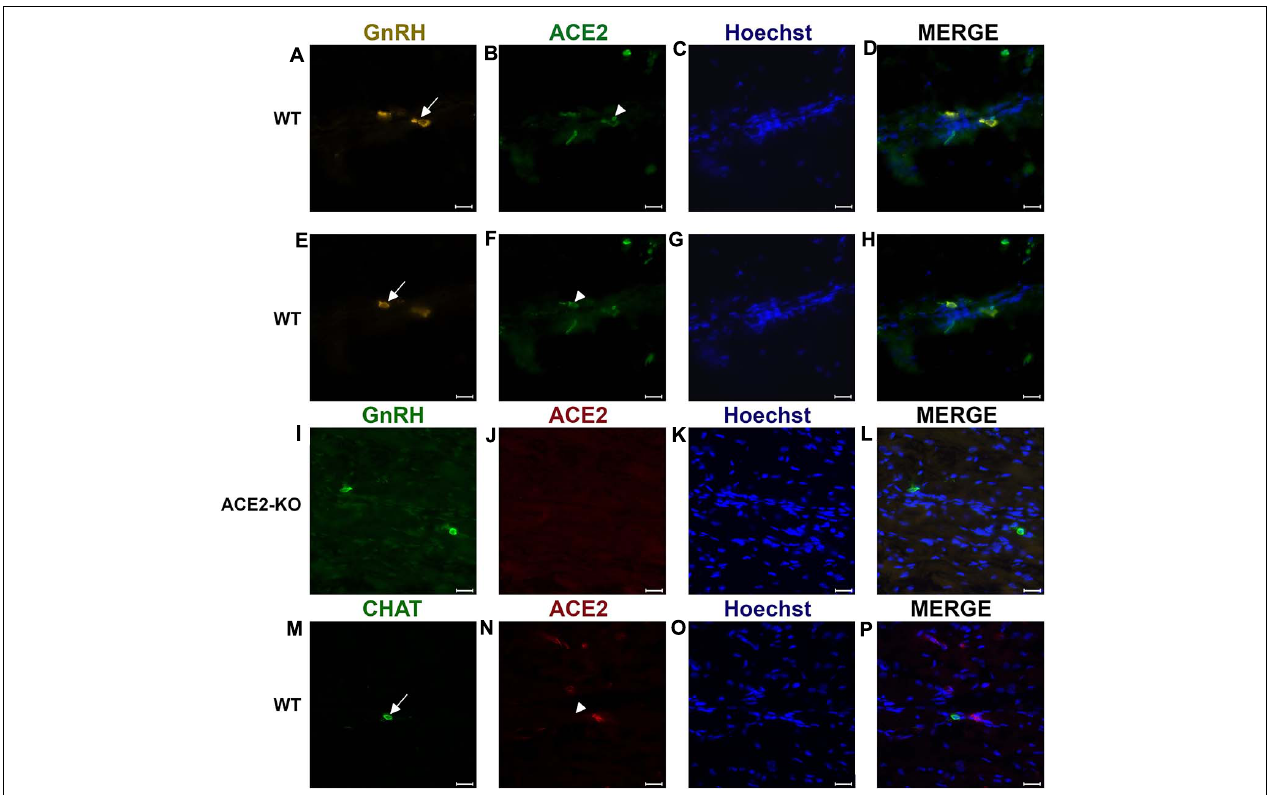
FIGURE 2 | Examples of double immunofluorescent labeling for nervus terminalis neuronal markers GnRH (A,E) or CHAT ( M ) and ACE2 (B,F,J,N) in the medial region adjacent to the olfactory bulbs as indicated in Figure 1 . ( A–H) Show slightly different focal planes to demonstrate the morphology of the two or three different neurons. Nuclei are stained with Hoechst 33258 (C,G,K,O) . Merged images are shown in the last column (D,H,L,P) . The neuronal somas labeled with GnRH (A,E) Are co-labeled with ACE2 (B,F) as shown after merging (D,H) . GnRH positive cells in the ACE2 knock-out mouse ( I ) are not labeled with ACE2 (J) . The majority of cholinergic neurons are not labeled with ACE2 (M,N) , as quantified in Figure 3A . Control sections probed without primary antibodies or with control rabbit IgG had no detectable signal (not shown). Arrows and triangles indicate double-labeled neurons or lack thereof. Scale bars: 20 µ